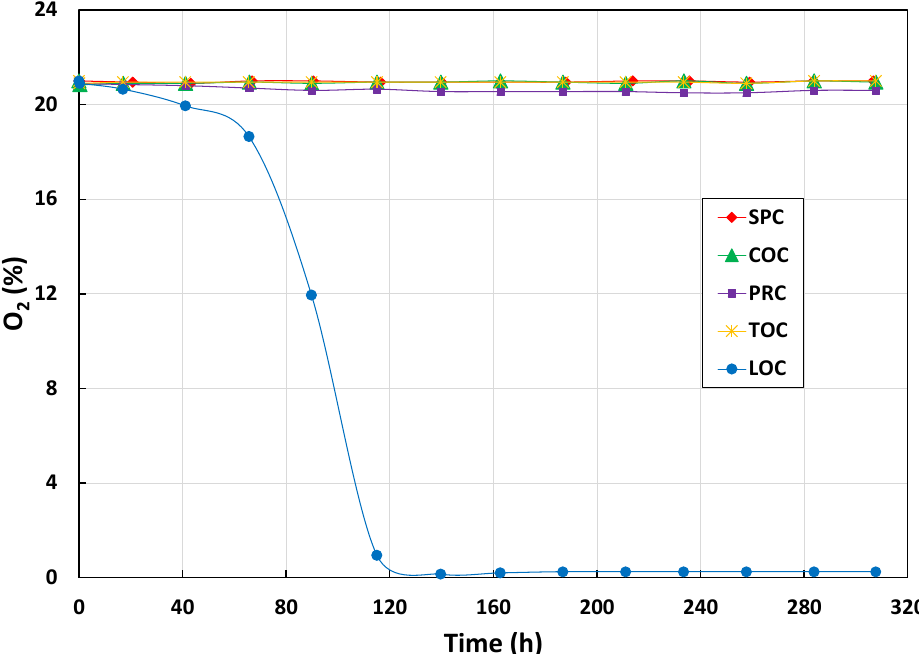
Figure 4. Residual oxygen (O 2 ) in the containers over the thirteen-day test period for each of the five materials. Pellets made from: SPC—100% synthetic pure cellulose, COC—cellulose plus 10% coconut oil, PRC—cellulose plus 10% pine rosin, LOC—cellulose plus 10% linseed oil, TOC—cellulose plus 10% tall oil.